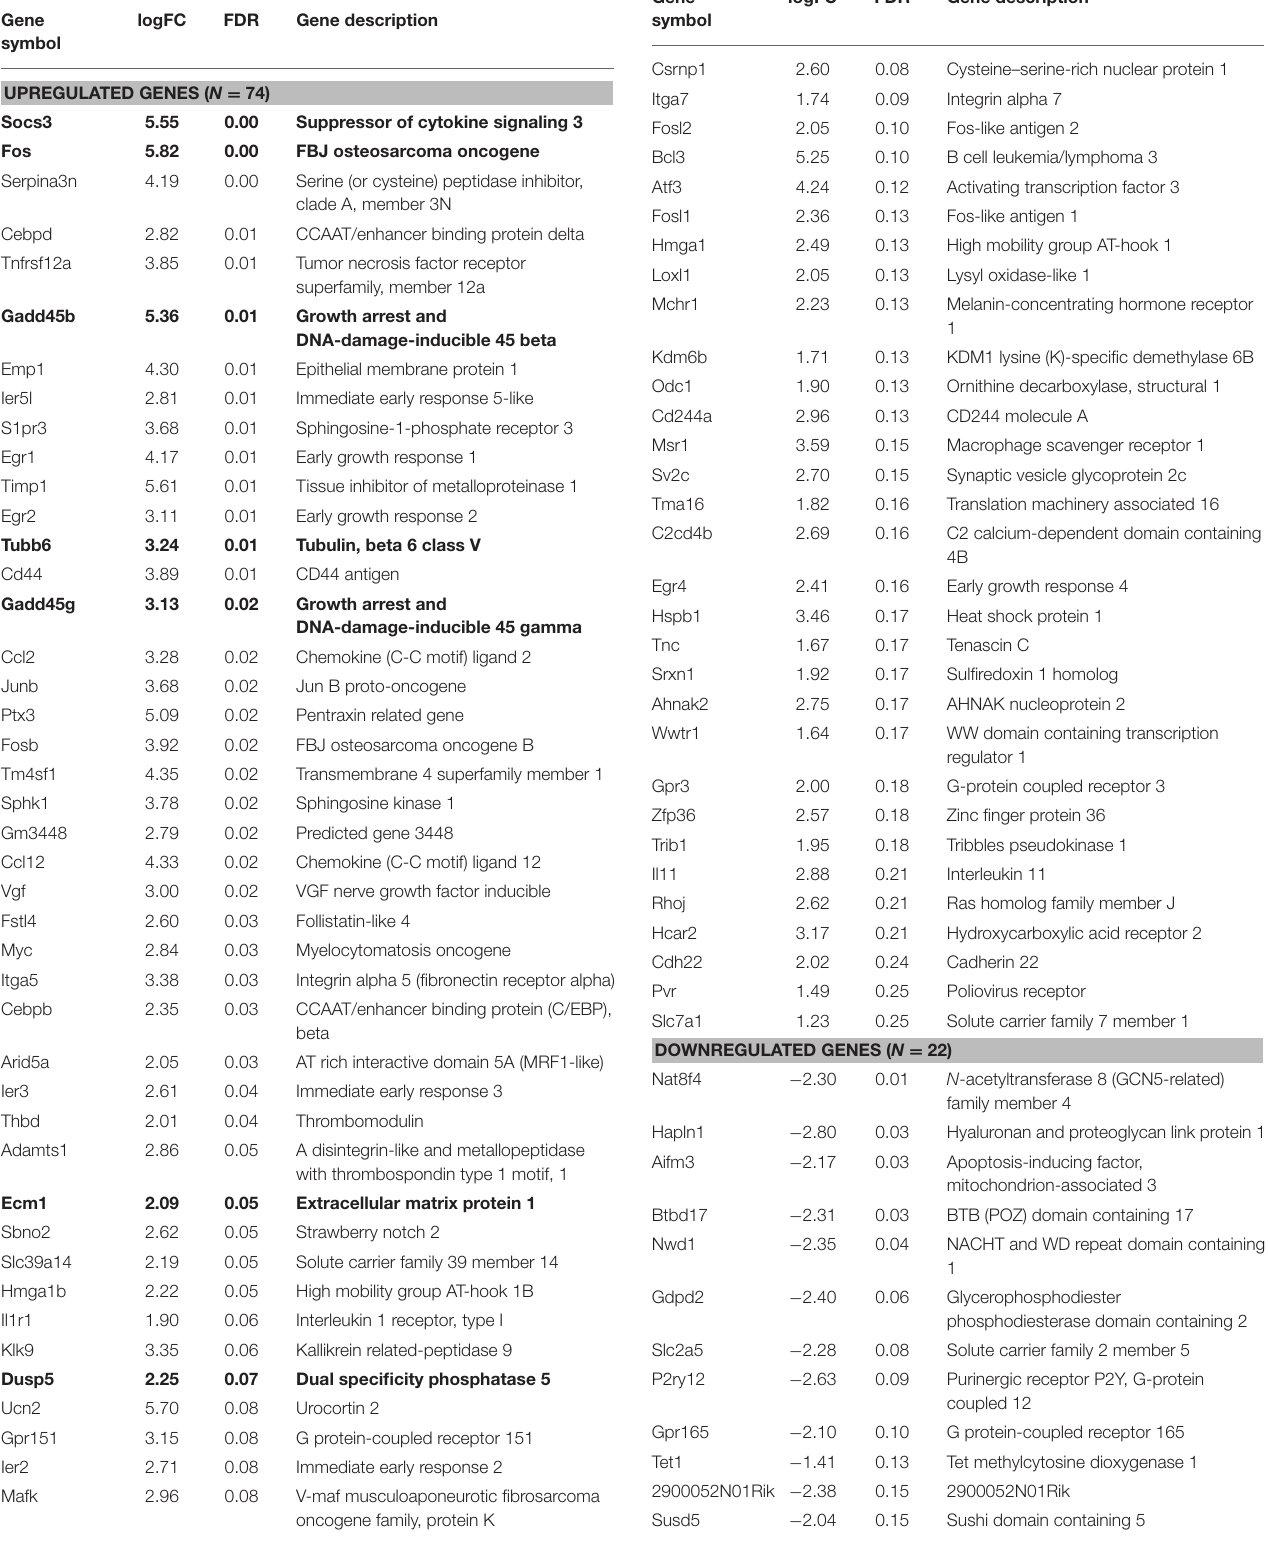
TABLE 2 | Differentially expressed genes in glia in the contralateral hippocampus (CLH) at 24h after kainate-induced status epilepticus. Gene logFC FDR Gene symbol